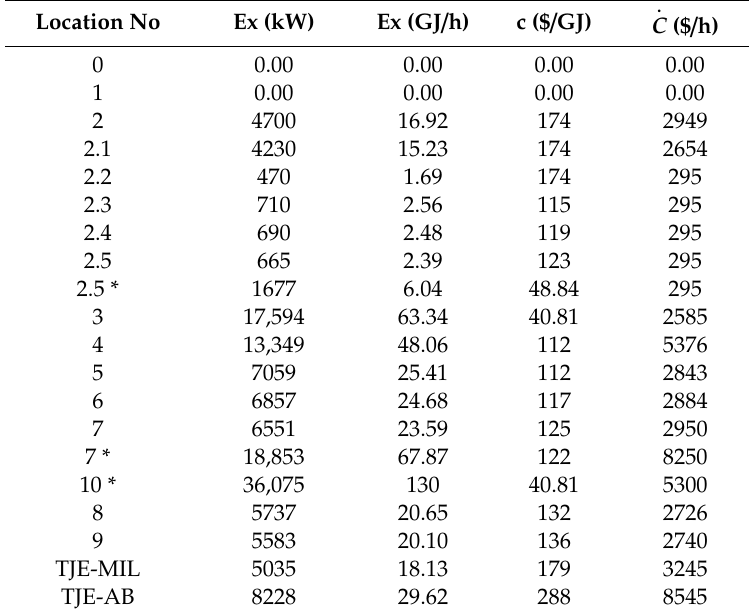
Table 7. Values for the cost rates of exergy flow and unit exergy related to process sections for hydrogen fuel use (*: exclusively AB PM).